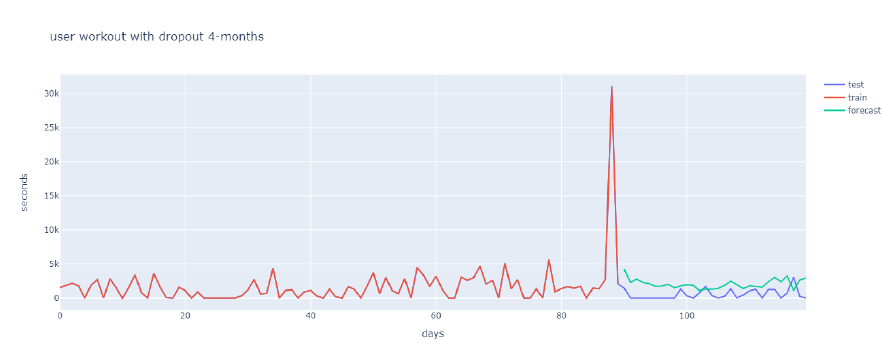
Figure 11. User 1 workout behaviour (four months).